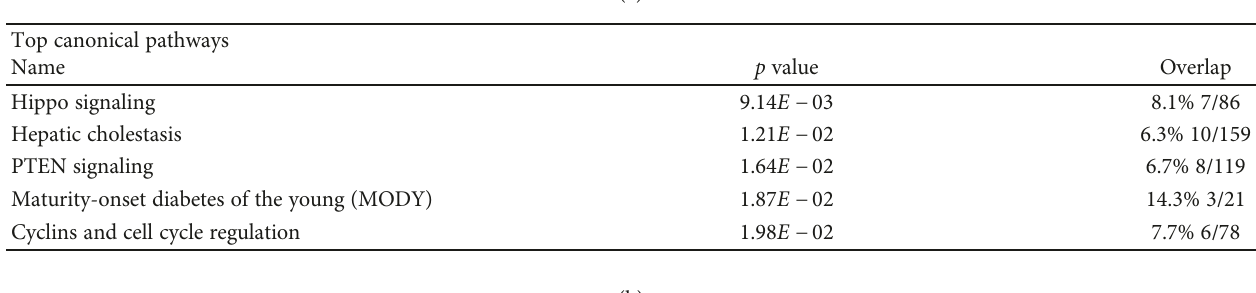
Table 1: Top canonical pathways, upstream regulators, diseases and biofunctions, and networks.